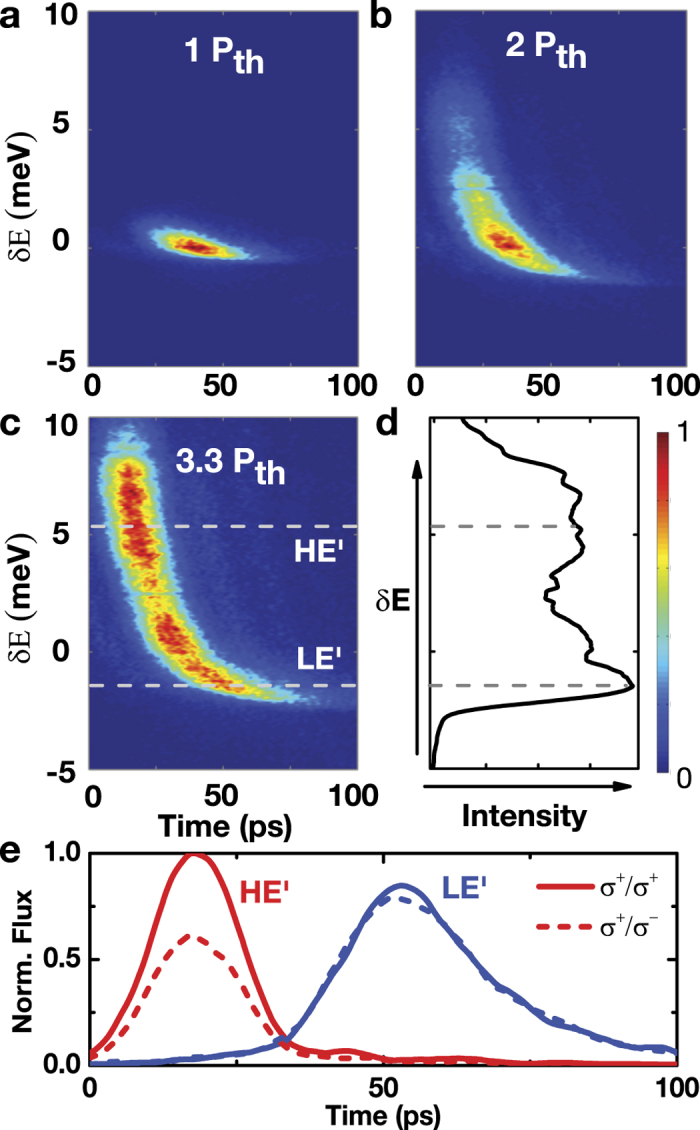
Dynamics.(a–c) Time-dependent spectra of the co-circular component at  under P = 1.0, 2.0, and 3.3 Pth. The energy δE is measured with respect to 1.415 eV, the lasing energy at the threshold. (d) The time-integrated spectrum obtained from (c). (e) Polarized time-dependent luminescence of the HE state at δE = 5 meV  as indicated in (c)] (solid and dashed red lines) and the LE state δE = −5 meV  as indicated in (c)] (solid and dashed blue lines) for P = 3.3 Pth.